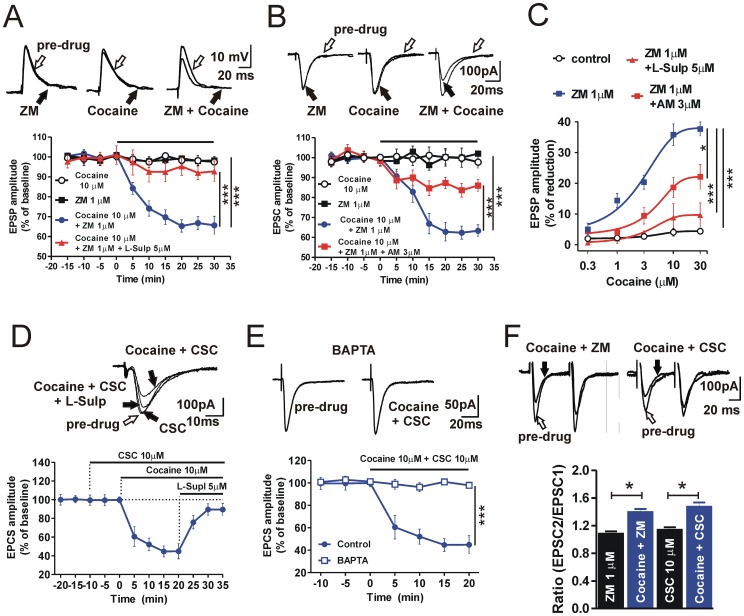
Effects of combined administration of cocaine and A2A-R antagonists on evoked EPSPs and EPSCs in striatal MSNs.(A) Graph of the time-course of EPSP amplitude recorded in the presence of cocaine (10 µM) or ZM241385 (ZM, 1 µM) given in isolation and cocaine plus ZM bath applied together with or without L-sulpiride (L-sulp, 5 µM), (cocaine plus ZM, vs cocaine F(9,72) = 14.8, P<0.001; cocaine plus ZM plus L-sulp, vs cocaine plu ZM F(9,72) = 6.6, P<0.001). Example of superimposed EPSP pairs (top traces) before and 30 min after the application of ZM, cocaine, or cocaine plus ZM. (B) Time-course of the EPSC amplitude in the presence of cocaine or ZM in isolation and cocaine plus ZM applied with or without AM251 (AM, 3 µM), (cocaine plus ZM, vs cocaine F(9,72) = 16.1, P<0.001; cocaine plus ZM plus AM, vs cocaine plus ZM, F(9,90) = 10.9, P<0.001). Example of EPSC superimposed pairs (top traces) before and 30 min after the application of ZM, cocaine, or cocaine plus ZM. (C) Dose-response curves of the reduction of the EPSP amplitudes induced by cocaine in control conditions and in the presence of either ZM, ZM plus AM or ZM plus L-sulp (5 µM), (cocaine plus ZM vs L-sulp plus cocaine plus ZM, F(4,24) = 7.3, P<0.001; cocaine plus ZM plus AM vs cocaine plus ZM, F(4,36) = 3.0, P<0.05). (D) Time-course showing the averaged EPSC amplitudes in the presence of 10 µM CSC, and after the subsequent application of CSC plus 10 µM cocaine. Note that the subsequent co-application of 5 µM L-sulp almost completely reverted the EPSC reduction achieved in the presence of CSC plus cocaine. EPSCs superimposed traces (top) recorded from a single striatal MSN in control condition (pre-drug), in CSC alone, in CSC plus cocaine, and in CSC plus cocaine plus L-sulp. (E) Time-course showing the lack of effect of cocaine plus CSC co-application on the EPSP amplitude measured in MSNs recorded either with a BAPTA-containing internal solution and with the standard solution (BAPTA internal solution, vs standard solution, F(6,54) = 26.1, P<0.001). Example EPSC traces measured from a MSN recorded with a BAPTA-containing electrode in control condition and after the co-application of 10 µM cocaine plus 10 µM CSC. (F) Histogram showing the increased EPSC ratios (EPSC2/EPSC1) in the presence of cocaine plus ZM or cocaine plus CSC in respect to pre-drug condition (cocaine plus ZM vs pre-drug, t(2) = 4.3, P<0.05; cocaine plus CSC vs pre-drug, t(2) = 6.4, P<0.05). *P<0.05; ***P<0.001.